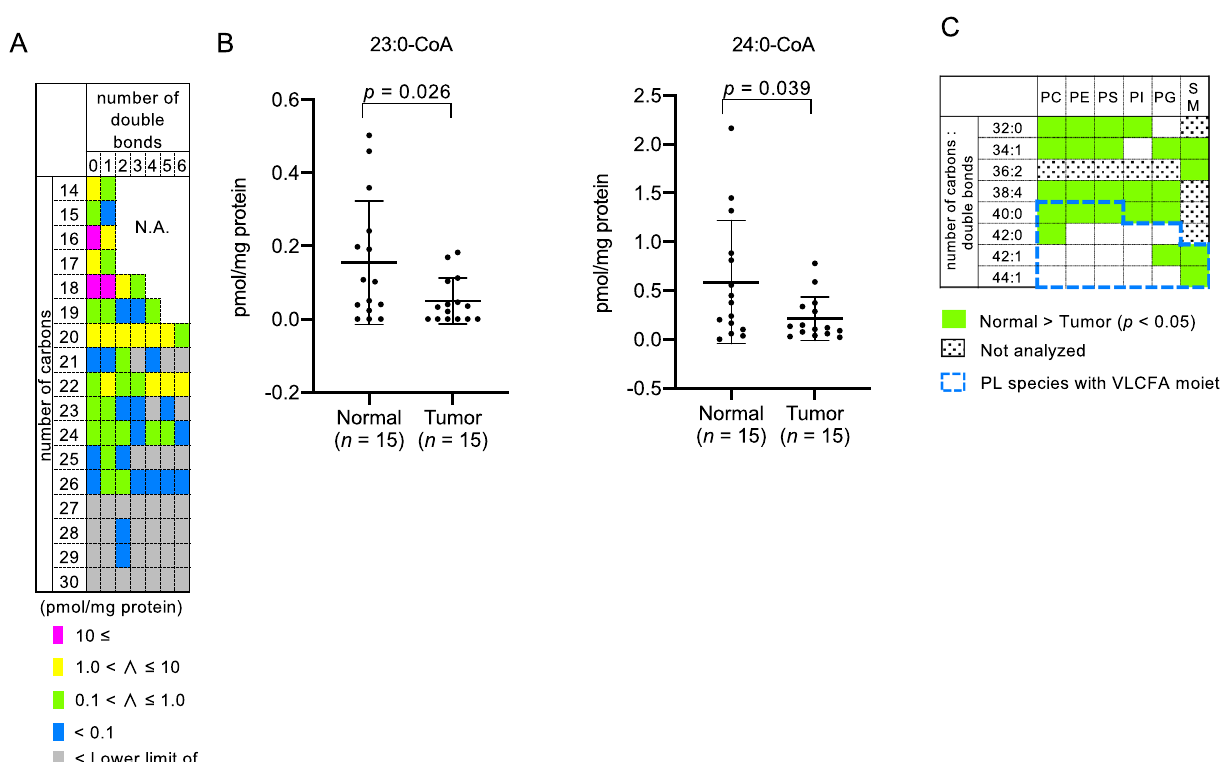
Figure 2. The amount of acyl-CoA, phospholipid (PL) and sphingomyelin (SM) species in colorectal cancer (CRC) tissues. ( A ) Each acyl-CoA species in adjunct normal tissues ( n = 15) was quantified and classified according to the number of carbon and double bonds in its acyl moiety. The ratio of the peak area for each acyl-CoA/D 31 -16:0-CoA was used to calculate the amount of each acyl-CoA species. The mean quantity of each acyl-CoA species in the tissues is represented with a color key. Data are also summarized in Supplementary Table S2 online. Acyl-CoA species observed to be present below the quantitation range are indicated in gray. The total amount of the top three acyl-CoA species (16:0-CoA, 18:0-CoA and 18:1-CoA) comprised more than 50% of the total amount of all acyl-CoA species, analyzed within the quantitative range. ( B ) The amount of 23:0-CoA and 24:0-CoA species in CRC and adjacent normal tissues. The amount of 23:0-CoA and 24:0-CoA species in CRC tissues was significantly lower than in adjunct normal tissues. ( C ) The amount of each PL and SM species was quantified using LC–MS in the positive ion mode. Lipid species present in quantities significantly lower in CRC ( n = 24) relative to adjacent normal tissues ( n = 24) are presented in lime. PL and SM species for which the multiple reaction monitoring (MRM) channels were not designed are indicated in the dot box. PL and SM species with a VLCFA moiety (C24:0 and C26:0) are indicated by the blue dashed line. Data represent the mean ± SD. Statistical analysis was performed using the two-tailed paired t -test in ( B , C species between CRC and normal tissues (Supplementary Fig. S3 online). These results showed that VLCFA were accumulated as esterified forms in TAG species, indicating that the TAG metabolism might be involved in the